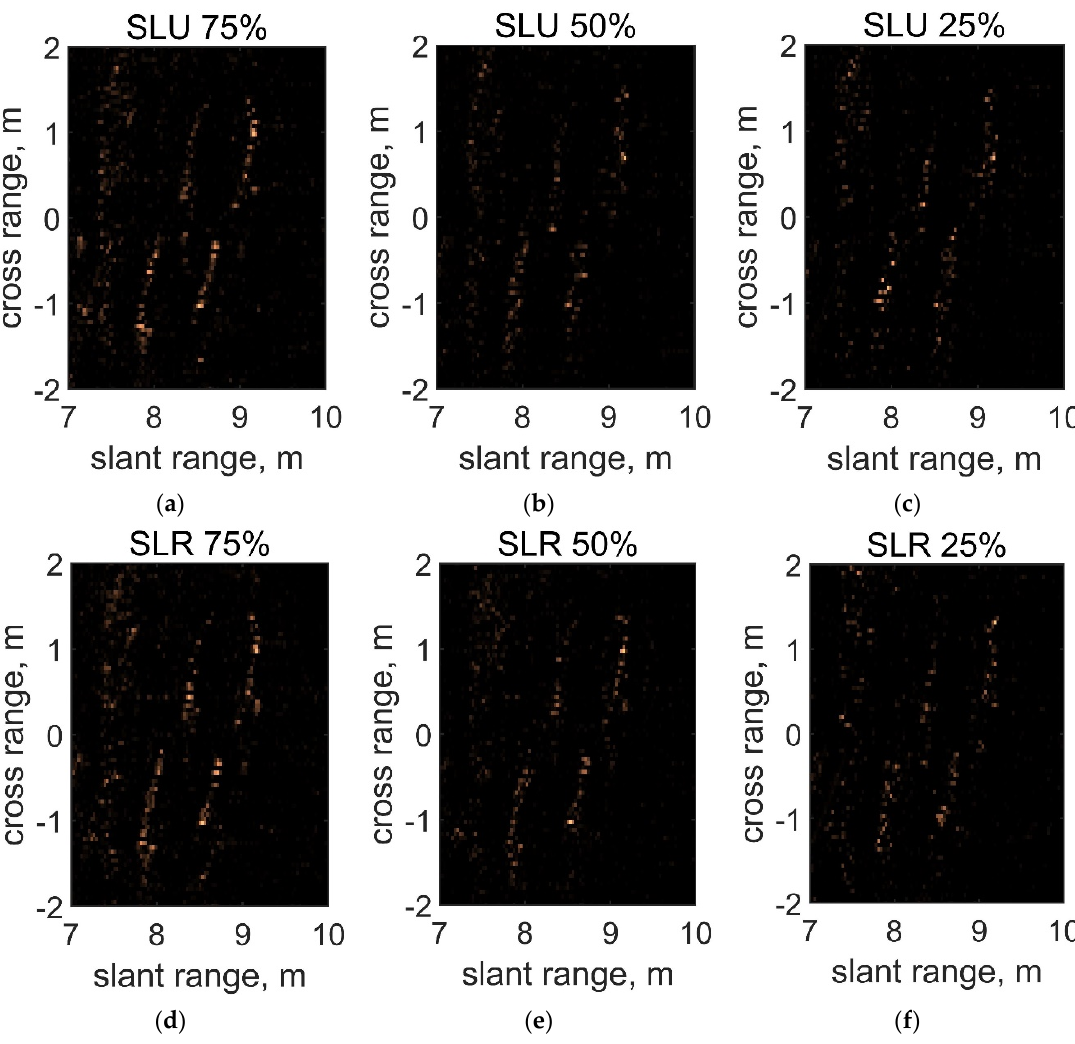
Figure 15. Results for some sensor loss conditions. Uniformly broken case (SLU) where the percentage of the remaining sensors are: ( a ) 75%; ( b ) 50%; ( c ) 25%. Randomly broken case (SRU) where the percentage of the remaining sensors are ( d ) 75%; ( e ) 50%; ( f ) 25%.